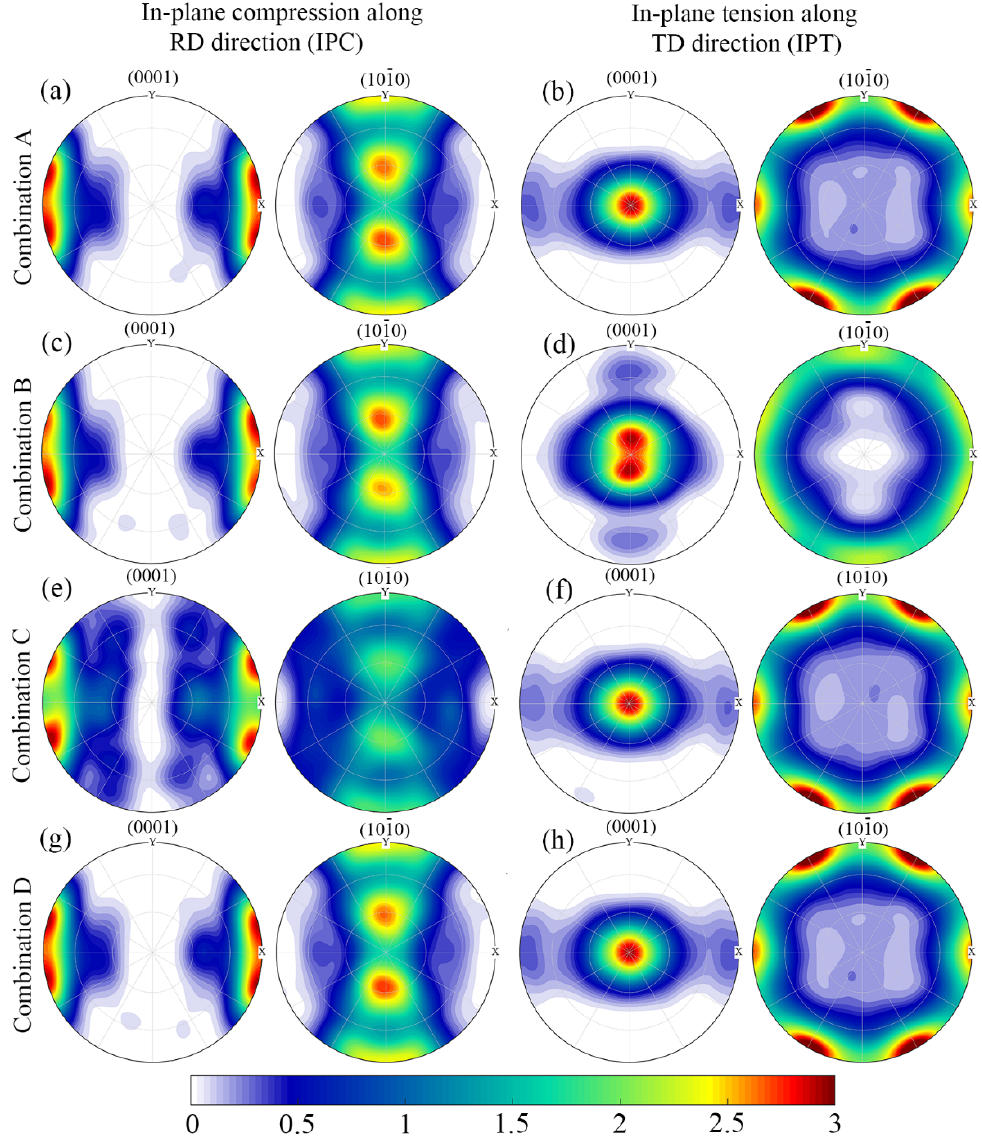
Figure 4. The predicted textures of the AZ31 magnesium alloy under uniaxial compression along RD and uniaxial tension along TD at the true strain of 0.15 based on various combinations of deformation mechanisms including ( a , b ) combination A; ( c , d ) combination B; ( e , f ) combination C; and ( g , h ) combination D.